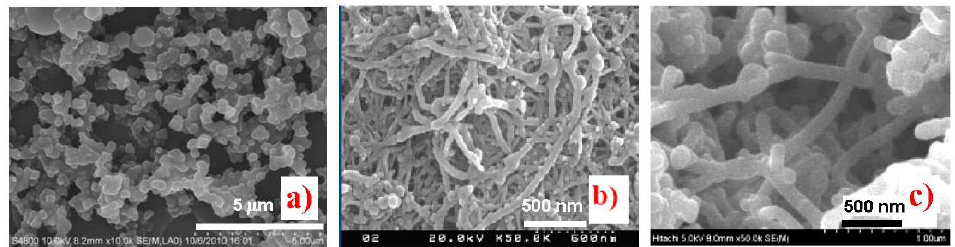
Figure 1. FESEM images of ( a ) PPy, scale bar 1 µm; ( b ) SWNTs, scale bar 500 nm; ( c ) PPy/SWNTs nanocomposite, scale bar 500 nm.